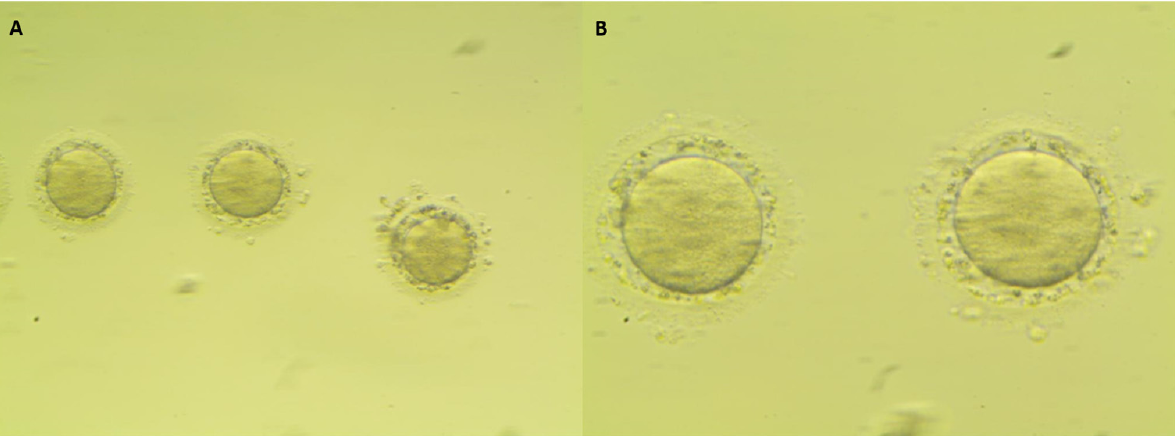
Figure 1. Details of dysmorphic oocytes: ( A ) cytoplasmic dimorphism with a burned-look alteration and ( B ) large perivitelline space with granules. Oocytes showed fragmented cytoplasm (( A ): 200 × ; ( B ) 400 × ).